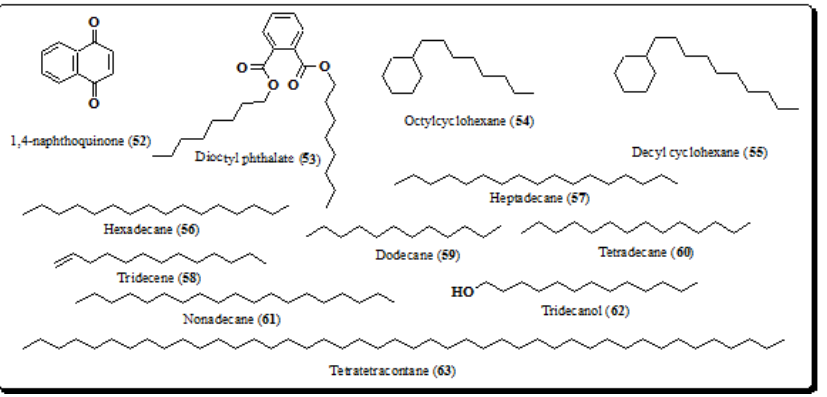
Figure 8. Structures of other compounds from E. laevis ( 52 – 63 ).